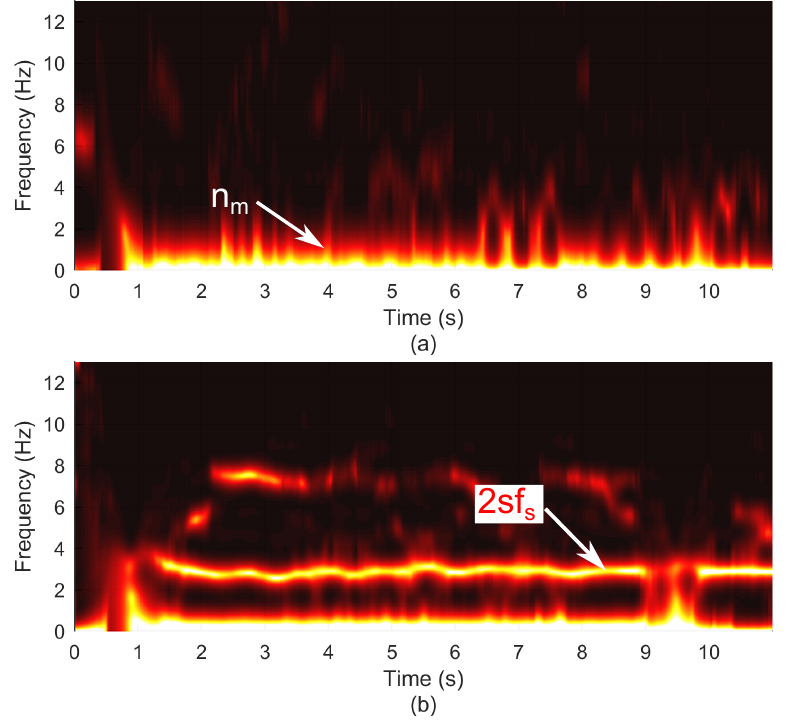
Figure 11. Time-frequency analyses of the motor speed under startup transient and low load level for: ( a ) healthy motor and ( b ) a rotor with one full broken rotor